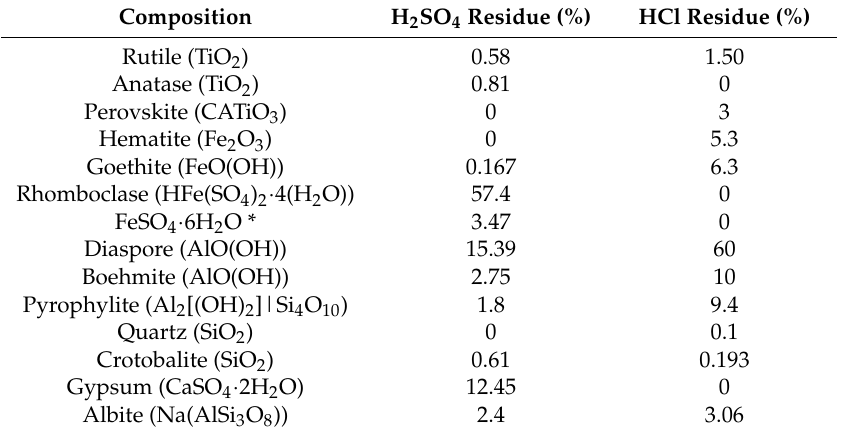
Table 2. Quantitative analyses of sulfuric acid (H 2 SO 4 ) and chloric acid (HCl) residues.